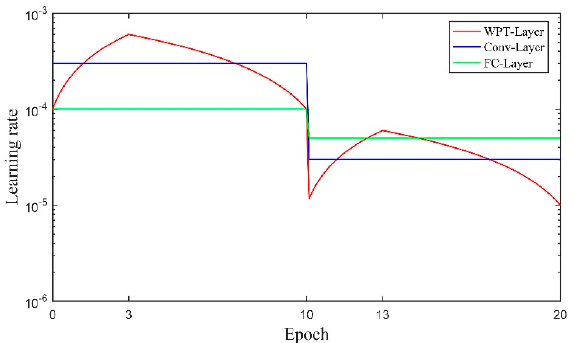
Figure 8. Learning rate schedules used for training di ff erent network layers in Case One.